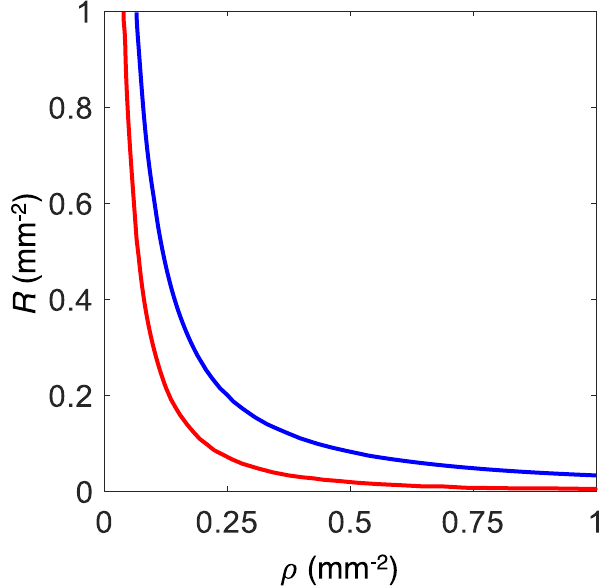
Fig. 7 | Comparison of the contributions of the multiple scattering and single backscattering components. Re fl ectance ( R ) is plotted vs. source-detector separation ( ρ ). The calculations are performed for typical optical properties of tissue: Henyey – Greenstein phase function, g =0.9, µ ' s =1.0mm − 1 , and µ a / µ ' s =0.01. Red line — single backscattering component, blue line — multiple scattering